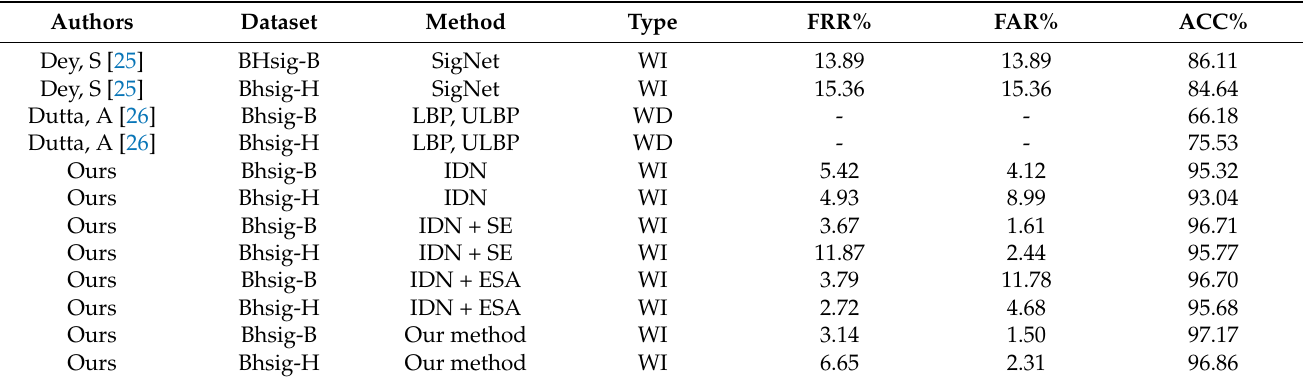
Table 3. Results of BHSIG260 data sets and comparative